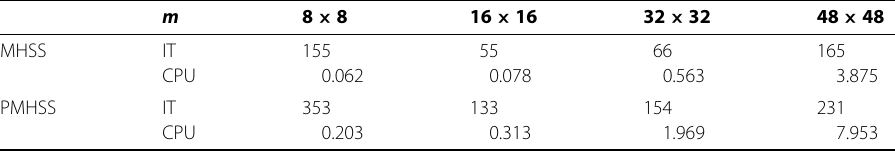
Table 2 CPU and IT for the MHSS-like and HSS-like methods m 8 × 8 16 × 16 32 × 32 48 × 48